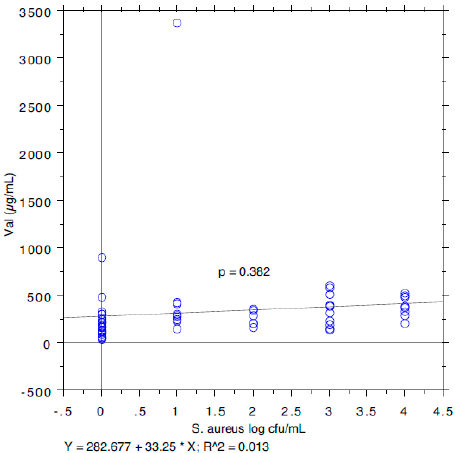
Figure 4. Pearson correlation between valine content and S . aureus load.